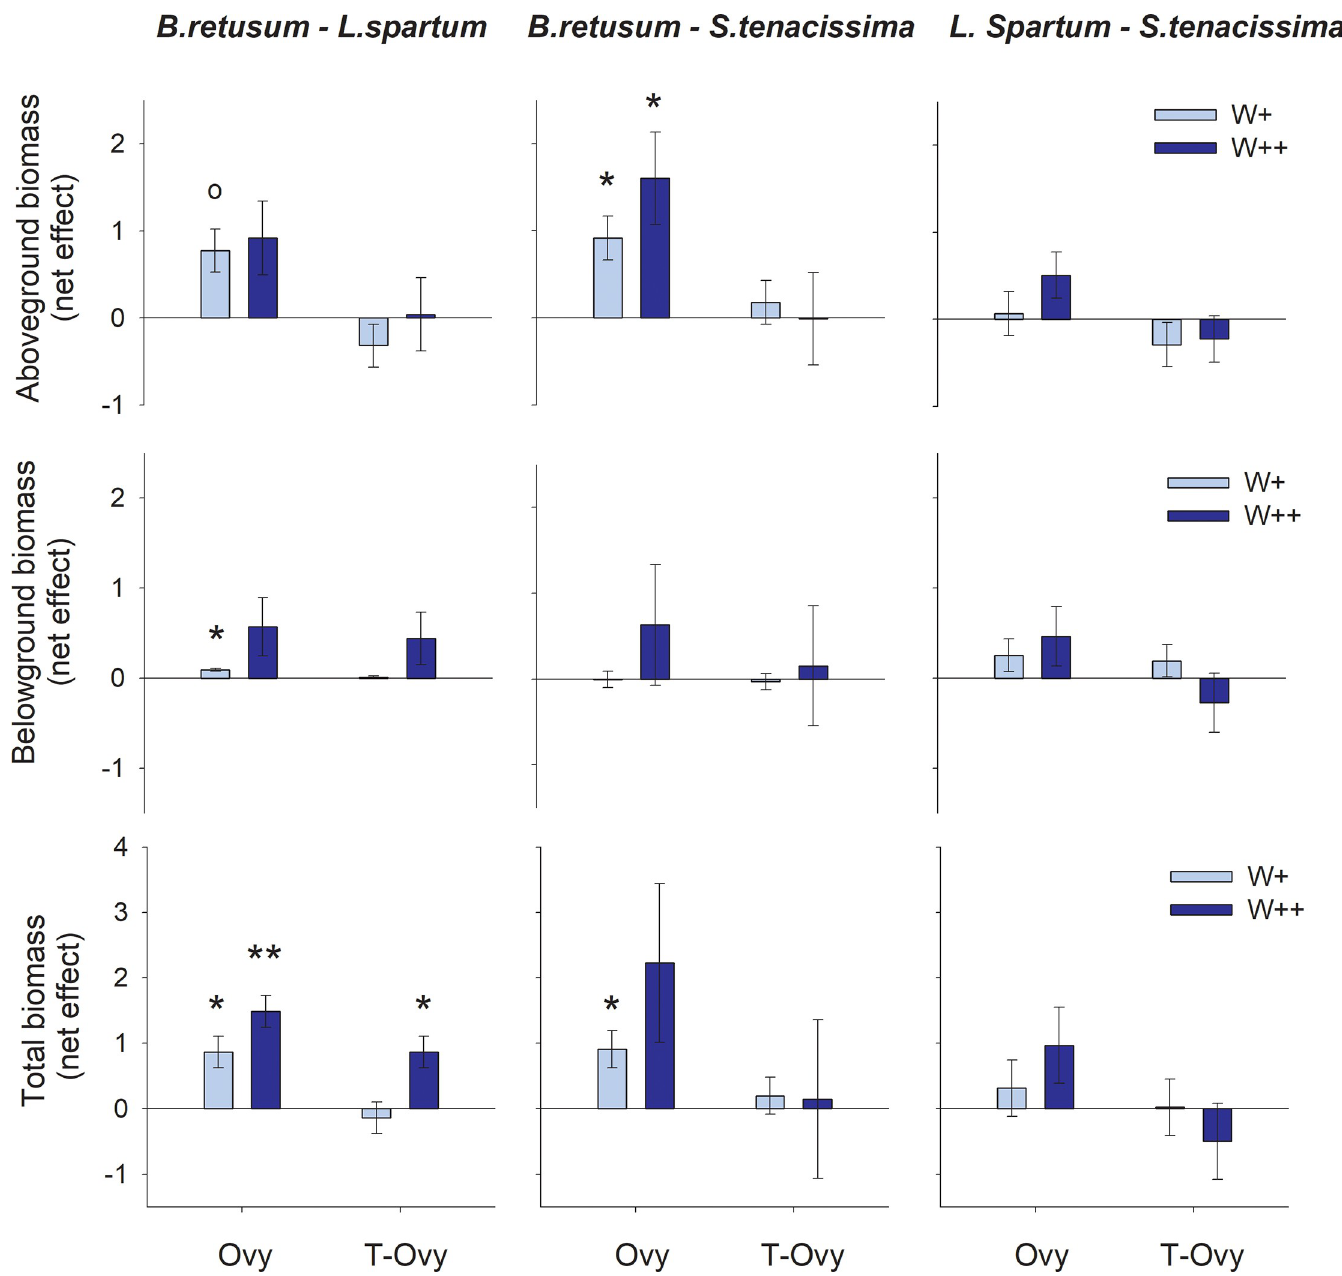
Fig 4. Net effect of species combination on culture biomass. Differences (net effect) in aboveground biomass (upper panel), belowground biomass (middle panel) and total biomass (lower panel) per pot (g) between the three target bi-specific cultures ( B . retusum—L . spartum ; B . retusum—S . tenacissima ; L . spartum—S . tenacissima ) and either the average of the respective monospecific cultures, i.e overyielding effect (Ovy), or the respective most productive monoculture, i.e transgressive overyielding (T-Ovy), for both frequent (W++) and reduced (W+) watering. Asterisks and empty circles represent, respectively, significant and marginally significant deviations of net effects from zero (two-tailed Student’s one-sample t-tests): p < 0.01 ( �� ), p < 0.05 ( � ), and p < 0.06